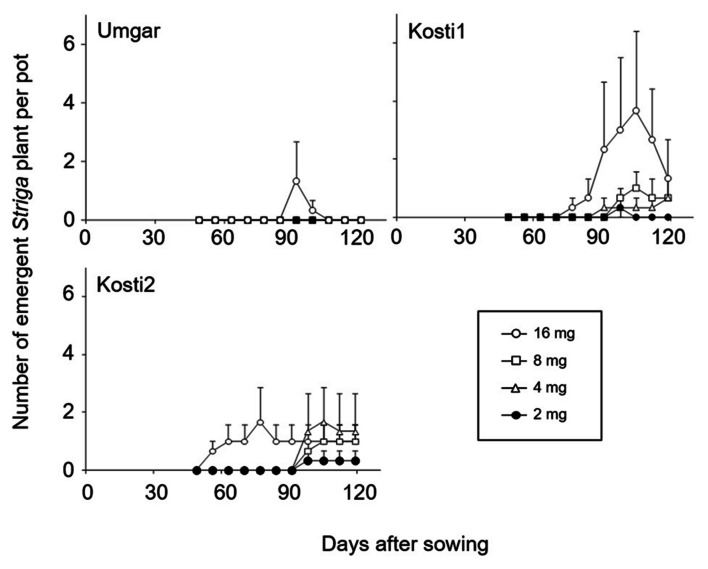
Number of emergent S. hermonthica plants per pots planted with rice. Umgar, Kosti1, and Kosti2 were used in the first pot experiment. The Striga seeds (2, 4, 8, and 16 mg) were mixed into top 5 cm of soil in each pot. Bars indicate standard errors of each mean value of three replications.